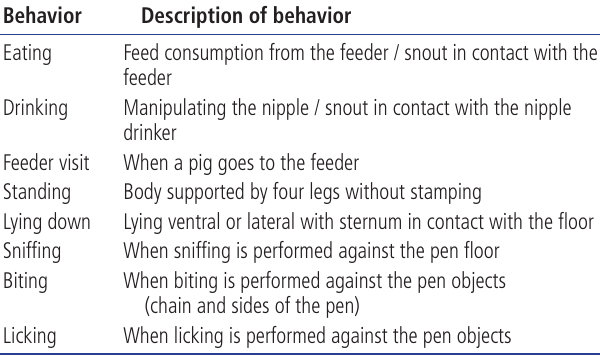
Table 3. Ethogram of recorded behavioral activities Behavior Description of